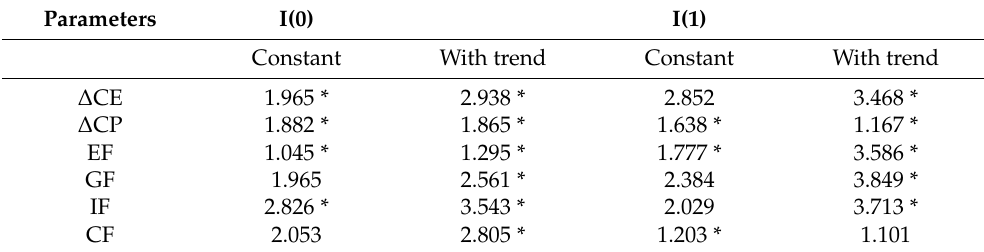
Table 2. Unit root